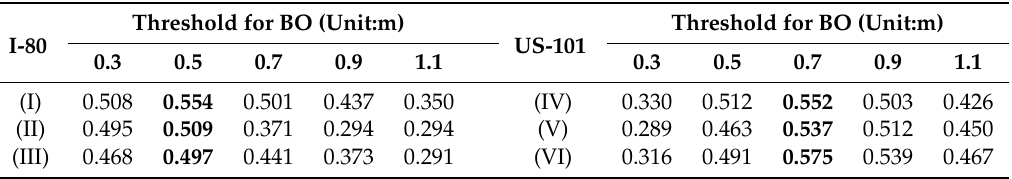
Table 2. Parameter comparison for boundary distance to the neighbor lanelines d BO .